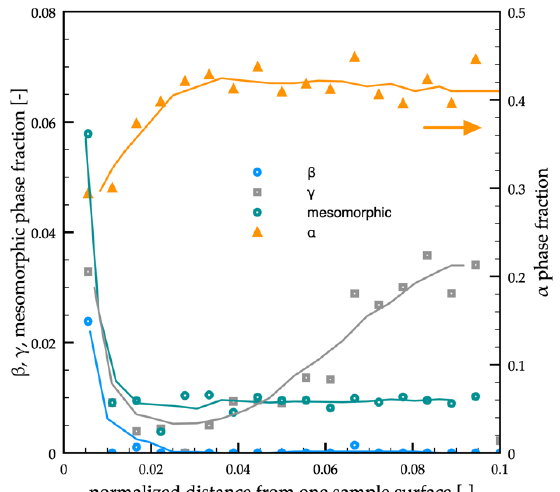
Figure 5. Distribution of mesomorphic, α, β, and γ-phases fractions evaluated from the WAXS analyses for the passive sample, up to 0.1 normalized distance from one sample surface.